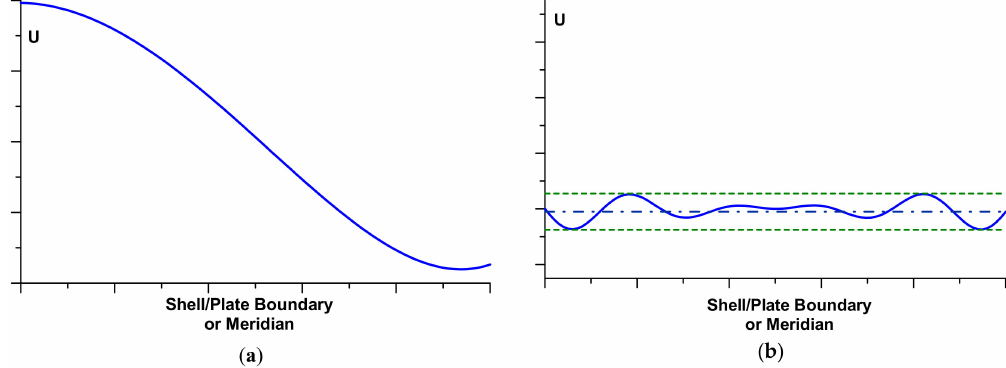
Figure 8. Variations of the objective functional U (the strain energy) along the nozzle opening. ( a ) initial. ( b ) final